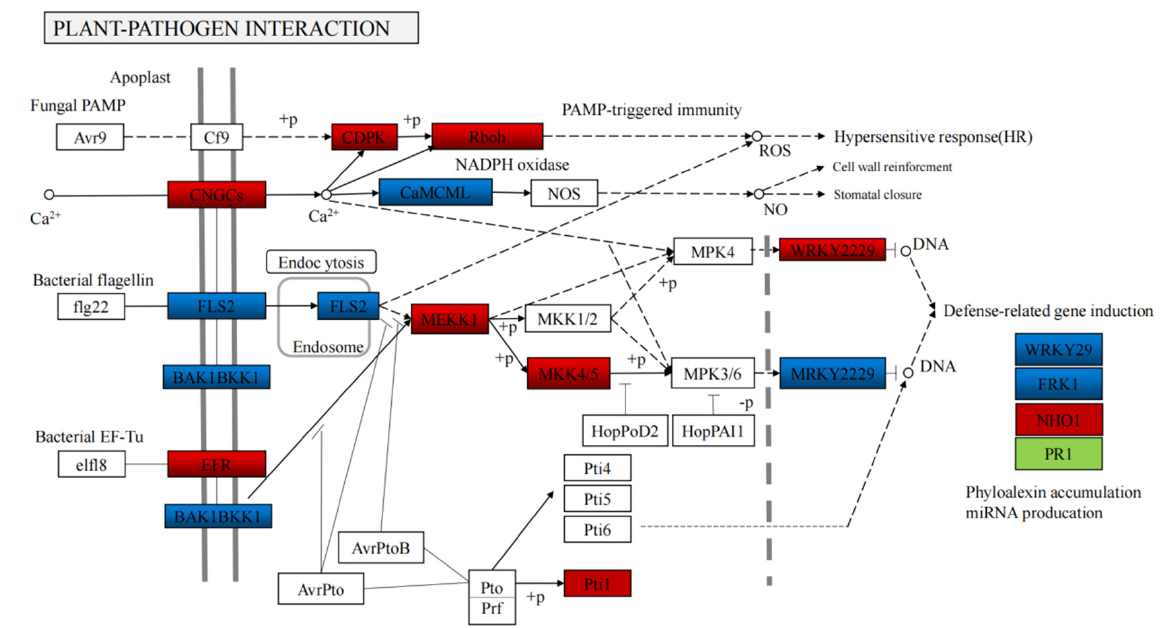
Figure 6. Differentially expressed genes divided into three different pathways based on gene ontol- ogy (GO).